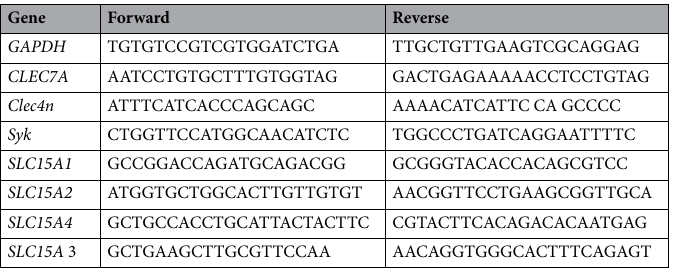
Table 1. Primer sequences used for quantitative real-time